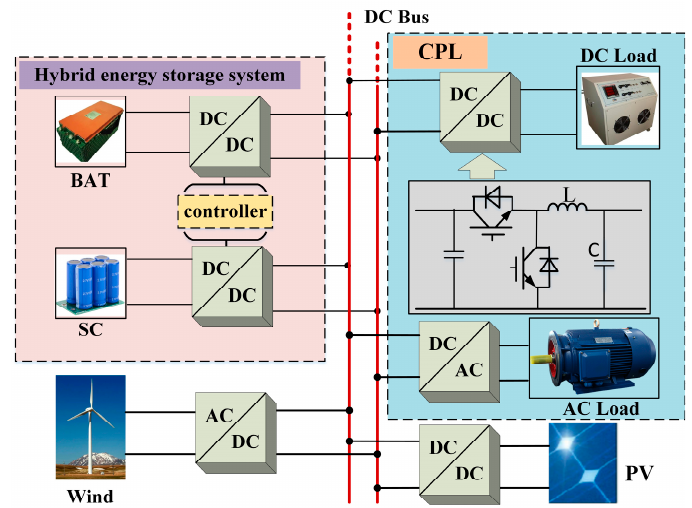
Figure 1. Structure of typical islanded DC microgrid.